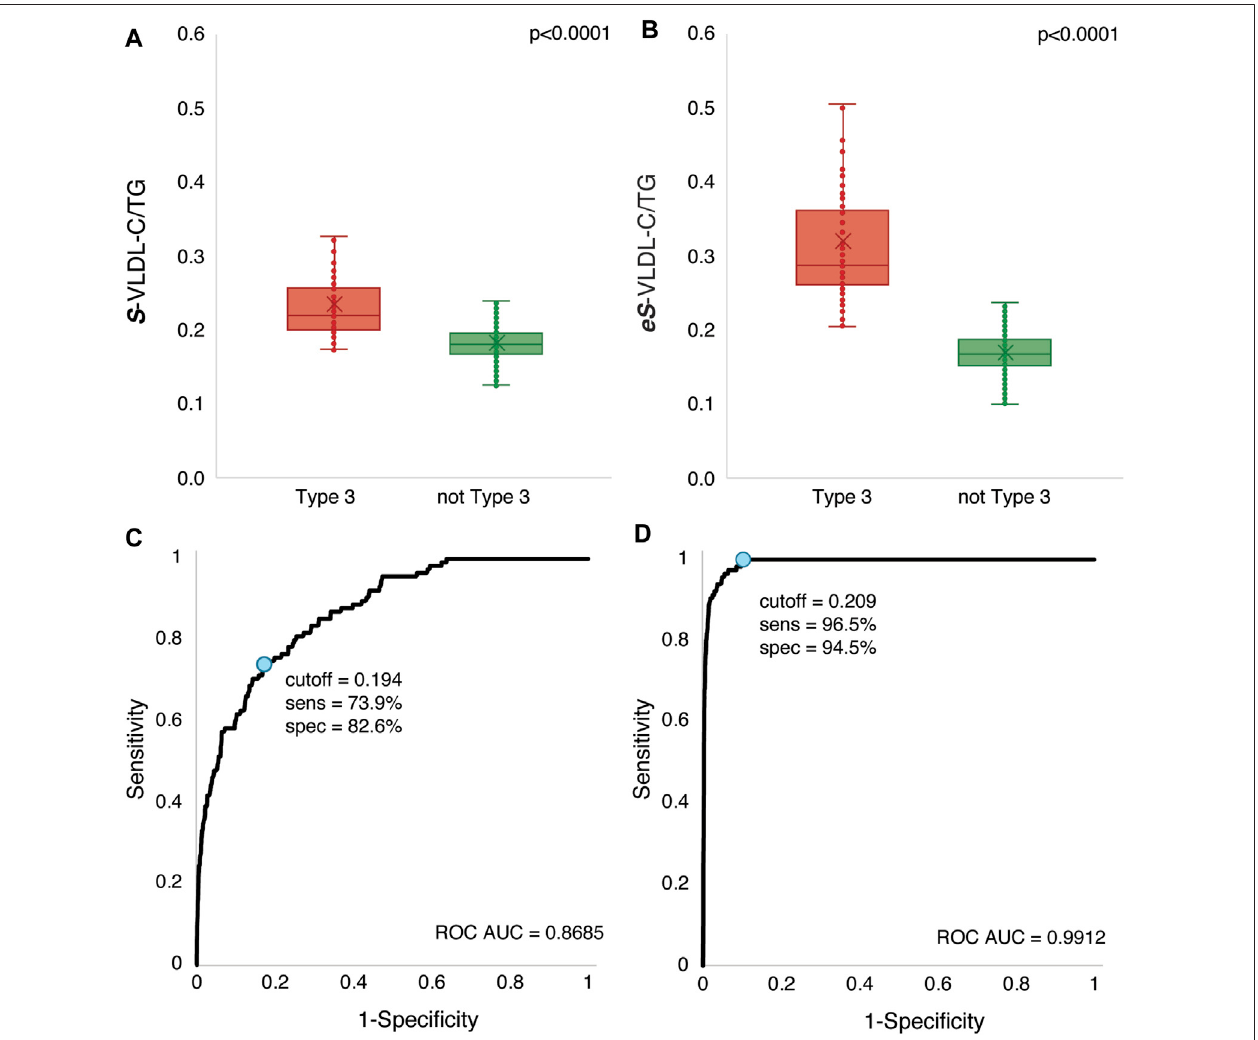
FIGURE 4 | VLDL-C/TG ratio comparison in HLP3 and non-HLP3 patients. VLDL-C wascalculated by the Sampson VLDL-C/TG ( S -VLDL-C/T) (A) and enhanced Sampson VLDL-C/TG ( eS -VLDL-C/T) (B) equations in the validation dataset (N = 12,405) from the results of a standard lipid panel. HLP3 was de fi ned as VLDL-C/TG > 0.3 mg/dlandTGbetween150 – 1,000 mg/dlusingtheBQresults.TheROCcurvesareplottedfortheSampsonVLDL-C/TG( S -VLDL-C/T) (C) andenhancedSampson VLDL-C/TG ( eS -VLDL-C/T) (D) equations. The optimal cut-point (blue circle) and its corresponding sensitivity and speci fi city are indicated for each equation.